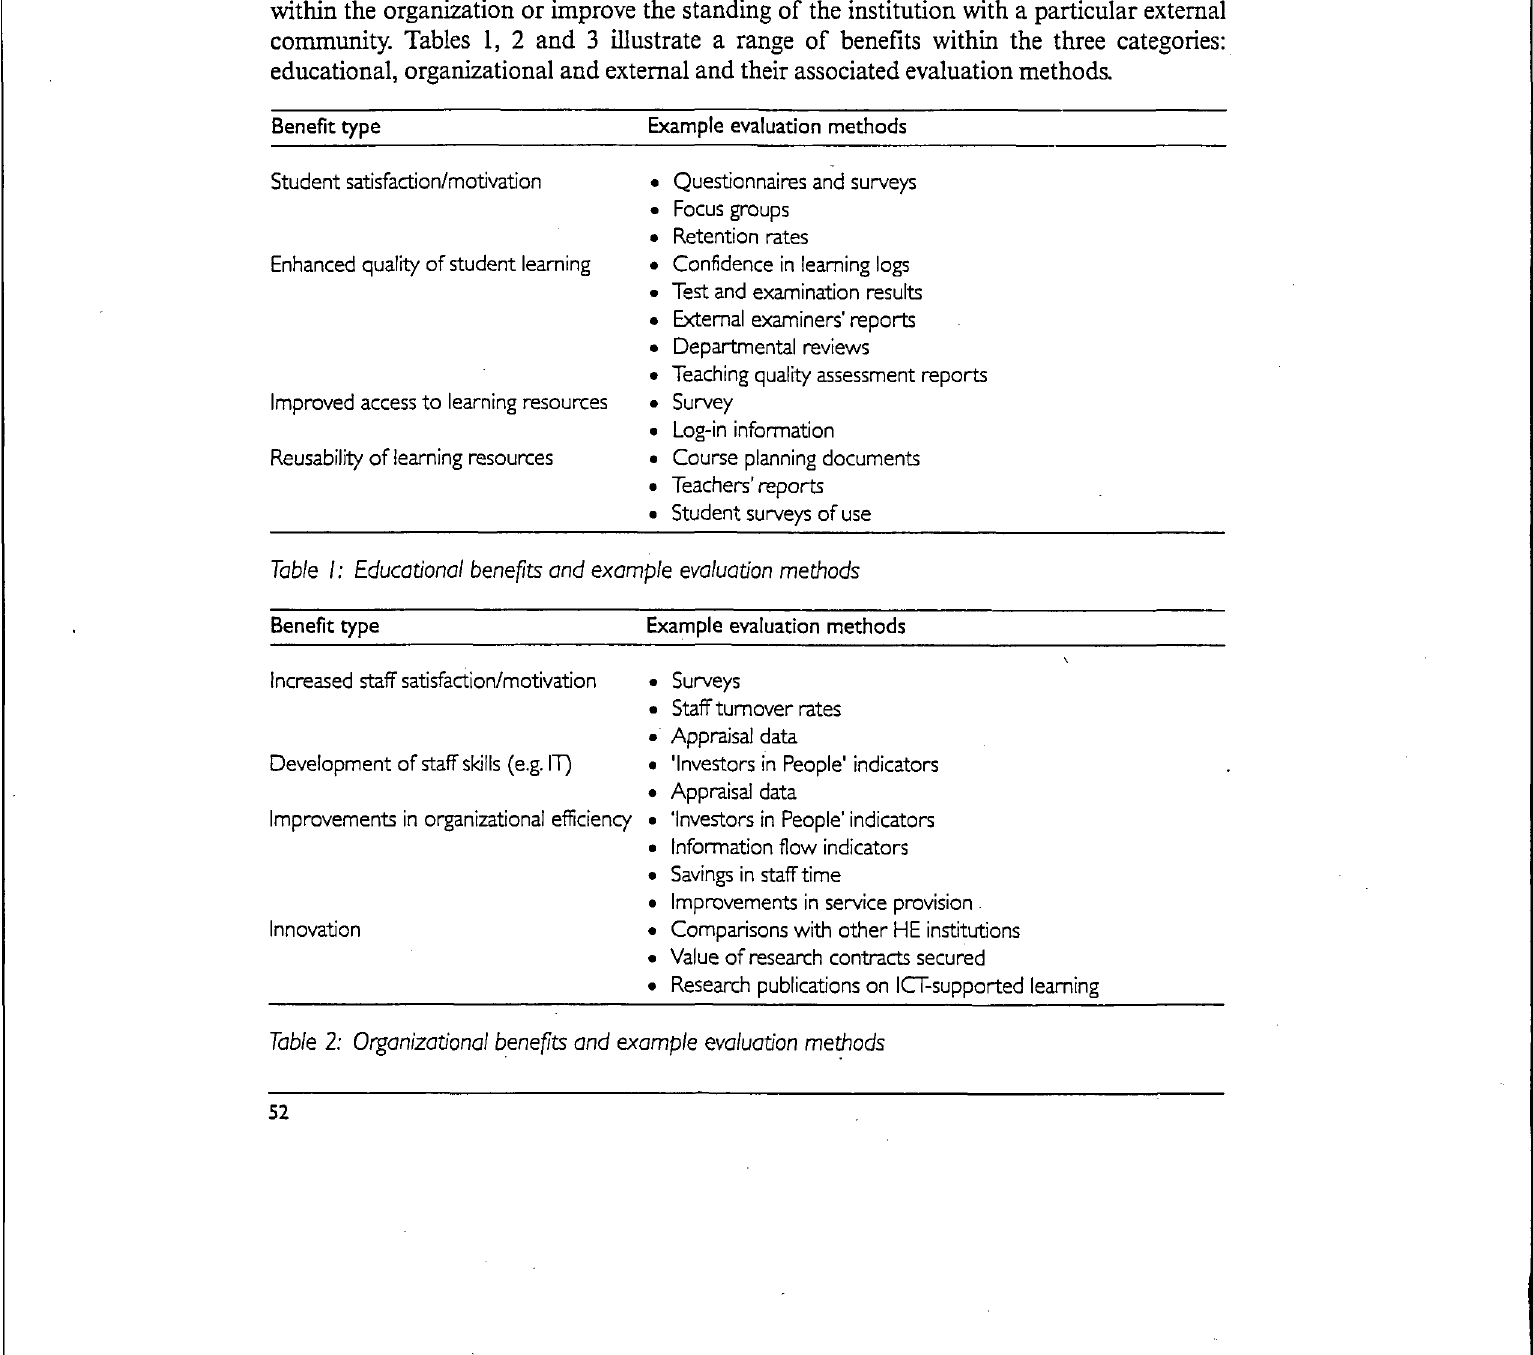
Table 2: Organizational benefits and example evaluation